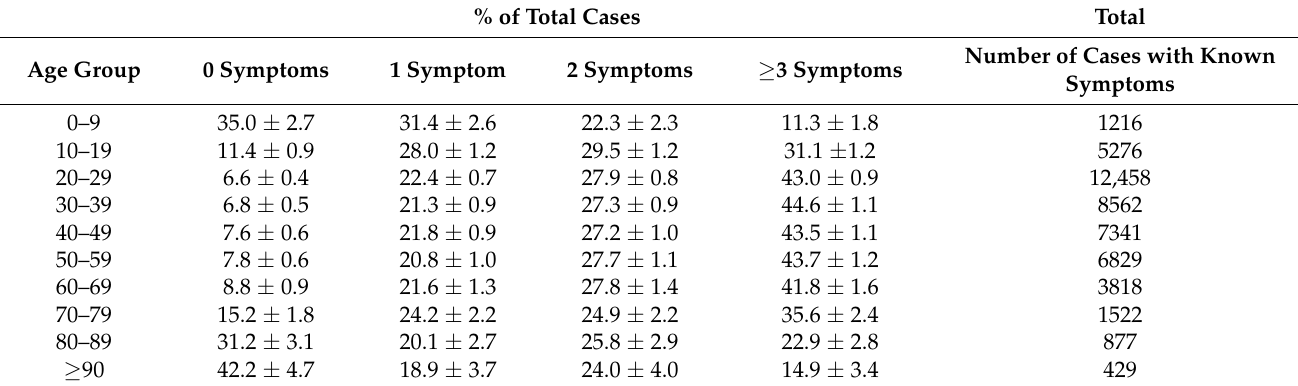
Table 1. Proportion of total cases with 0, 1, 2, or ≥ 3